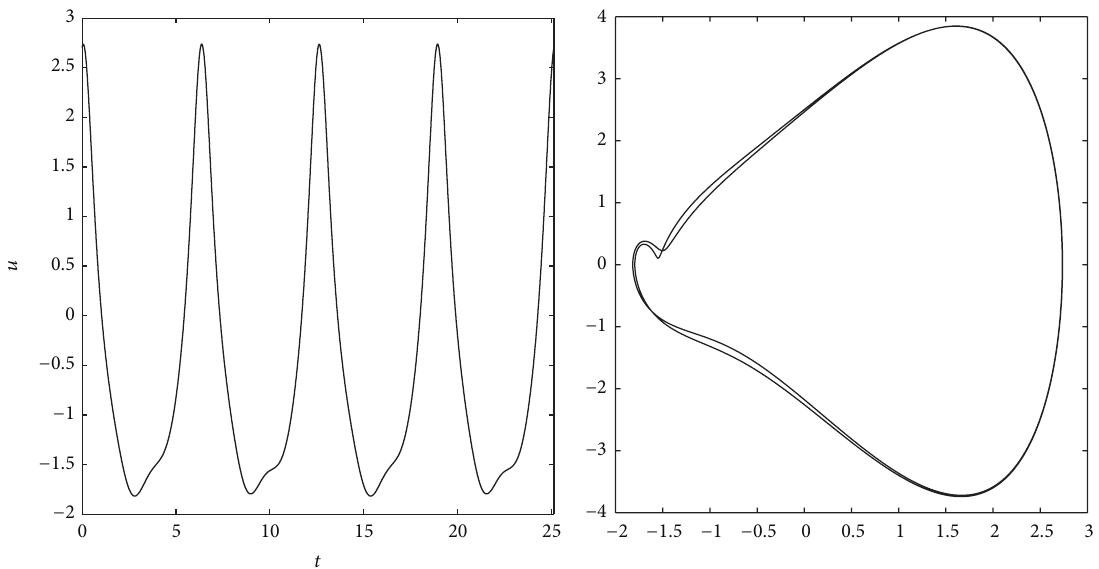
Figure 3: These results show the numerical solution on [ 0,8𝜋 ] (left) and the trajectories in the phase plane (right) for Example 3. The periodicity can be observed by the profiles of the trajectories in the phase